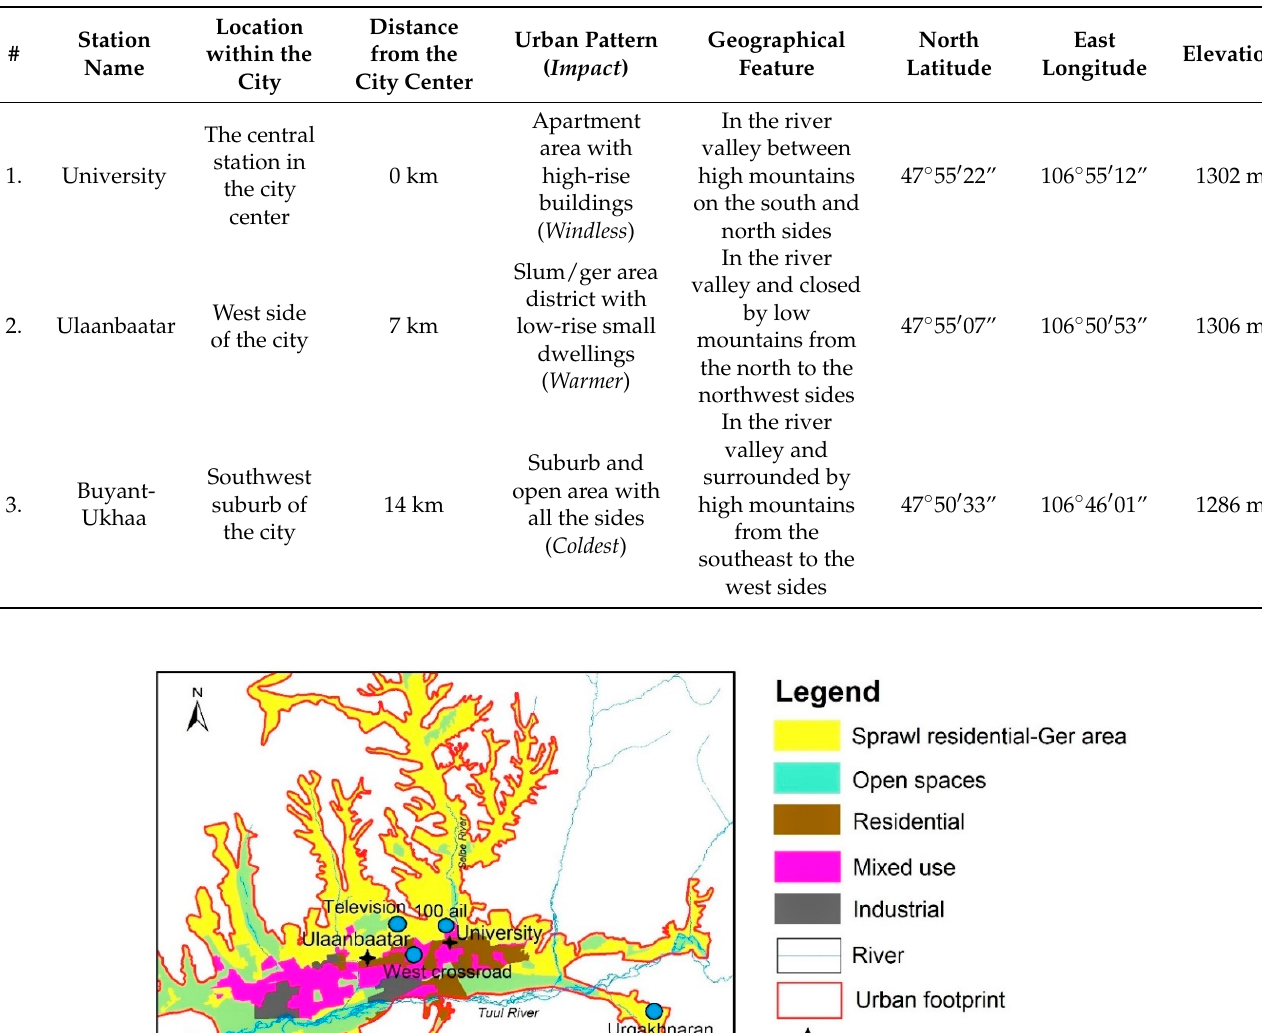
Table 1. Location of the weather stations in Ulaanbaatar city.